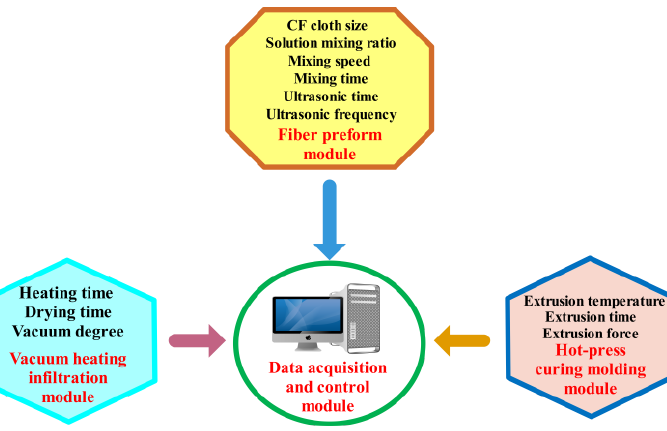
Figure 1. Vacuum infiltration hot-pressing experimental system.